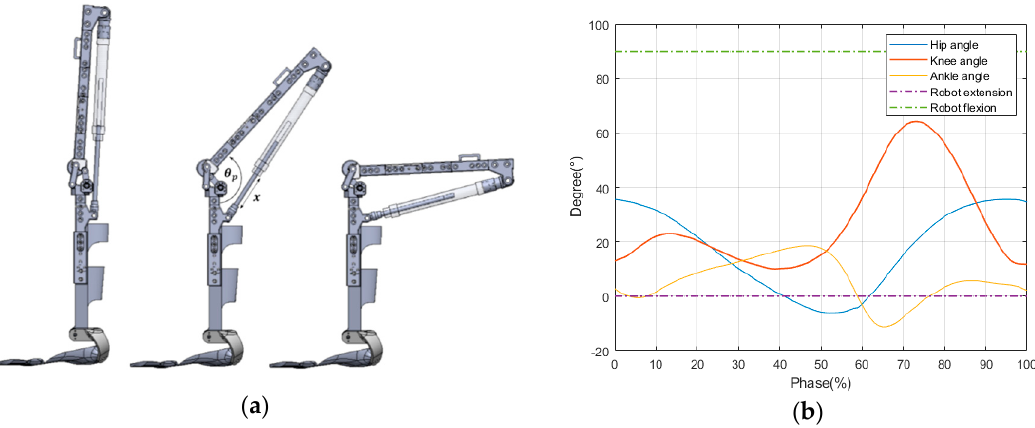
Figure 2. Range of motion of the designed polycentric knee exoskeleton: ( a ) design modeling of the polycentric knee exoskeleton; ( b ) normal angle and workspace of the robot during the gait cycle.